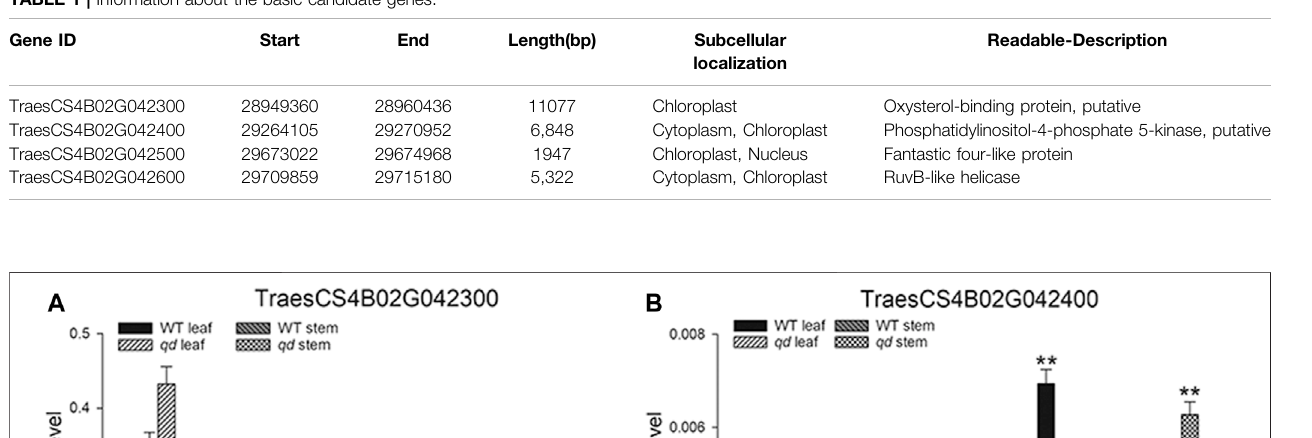
Frontiers in Genetics |